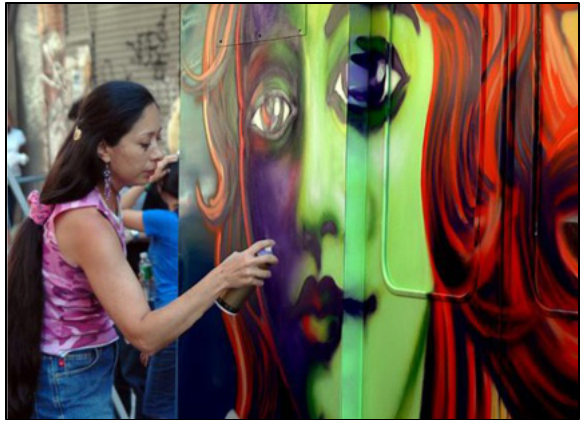
Figure1. Lady Pink, Graffiti artist. ( False Prophet